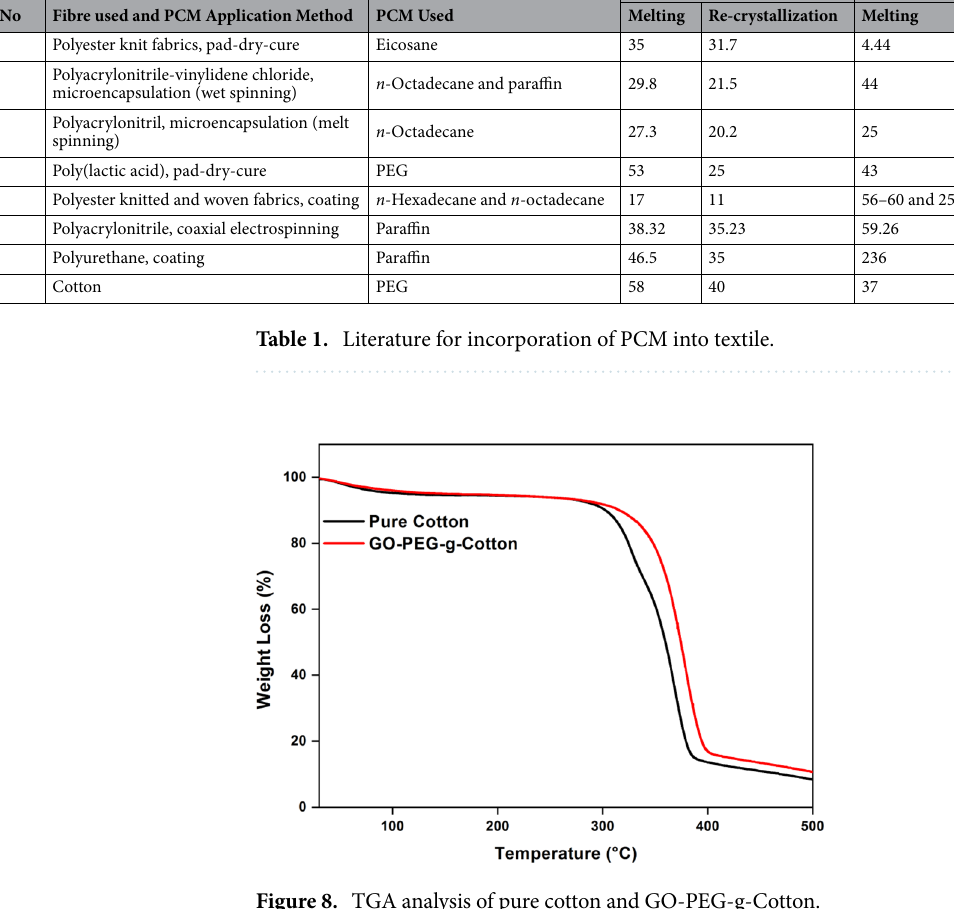
Figure 8. TGA analysis of pure cotton and